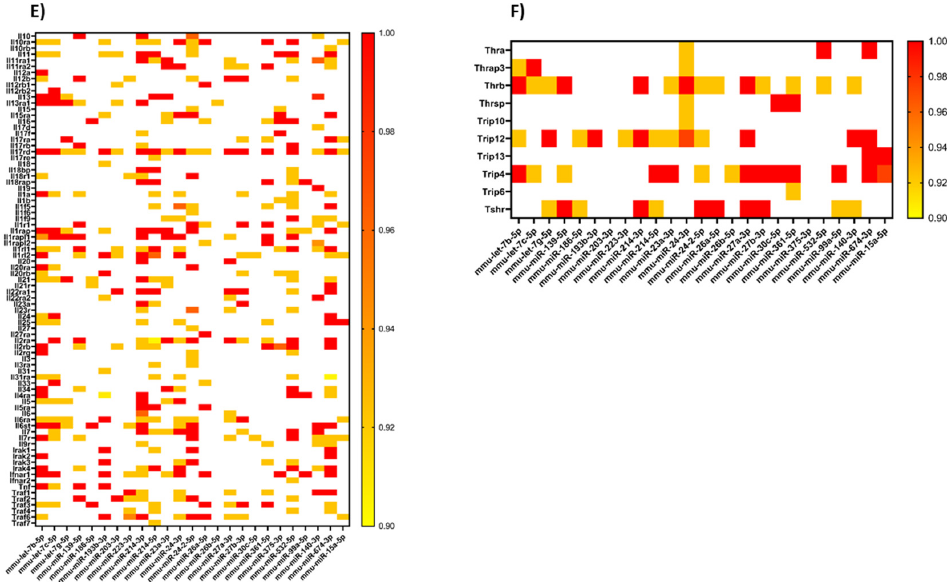
2 Figure 3. The mRNAs regulated by miRNAs, changed after stress in the serum of three genotypes (WT, NET-KO and SWR / J) of mice. The mRNAs were divided into six groups: receptors of monoamines and their transporters ( A ), neurotrophic factors, neuropeptides and their receptors together with glucocorticoid receptors ( B ), glutamate receptors and transporters ( C ), gamma-aminobutyric acid (GABA) receptors and transporters ( D ), interleukins and tumor necrosis factor together with the receptors as well as interferon receptors ( E ), thyroid hormone receptors ( F ). The relationship between mRNAs (placed on the left side) and the regulating miRNAs (placed at the bottom) are presented as heatmaps. The strength of probability of miRNA–mRNA interaction is shown as the p value and is color-coded (the scales presented on the right side of the heatmaps). The highest p value was indicated in red.